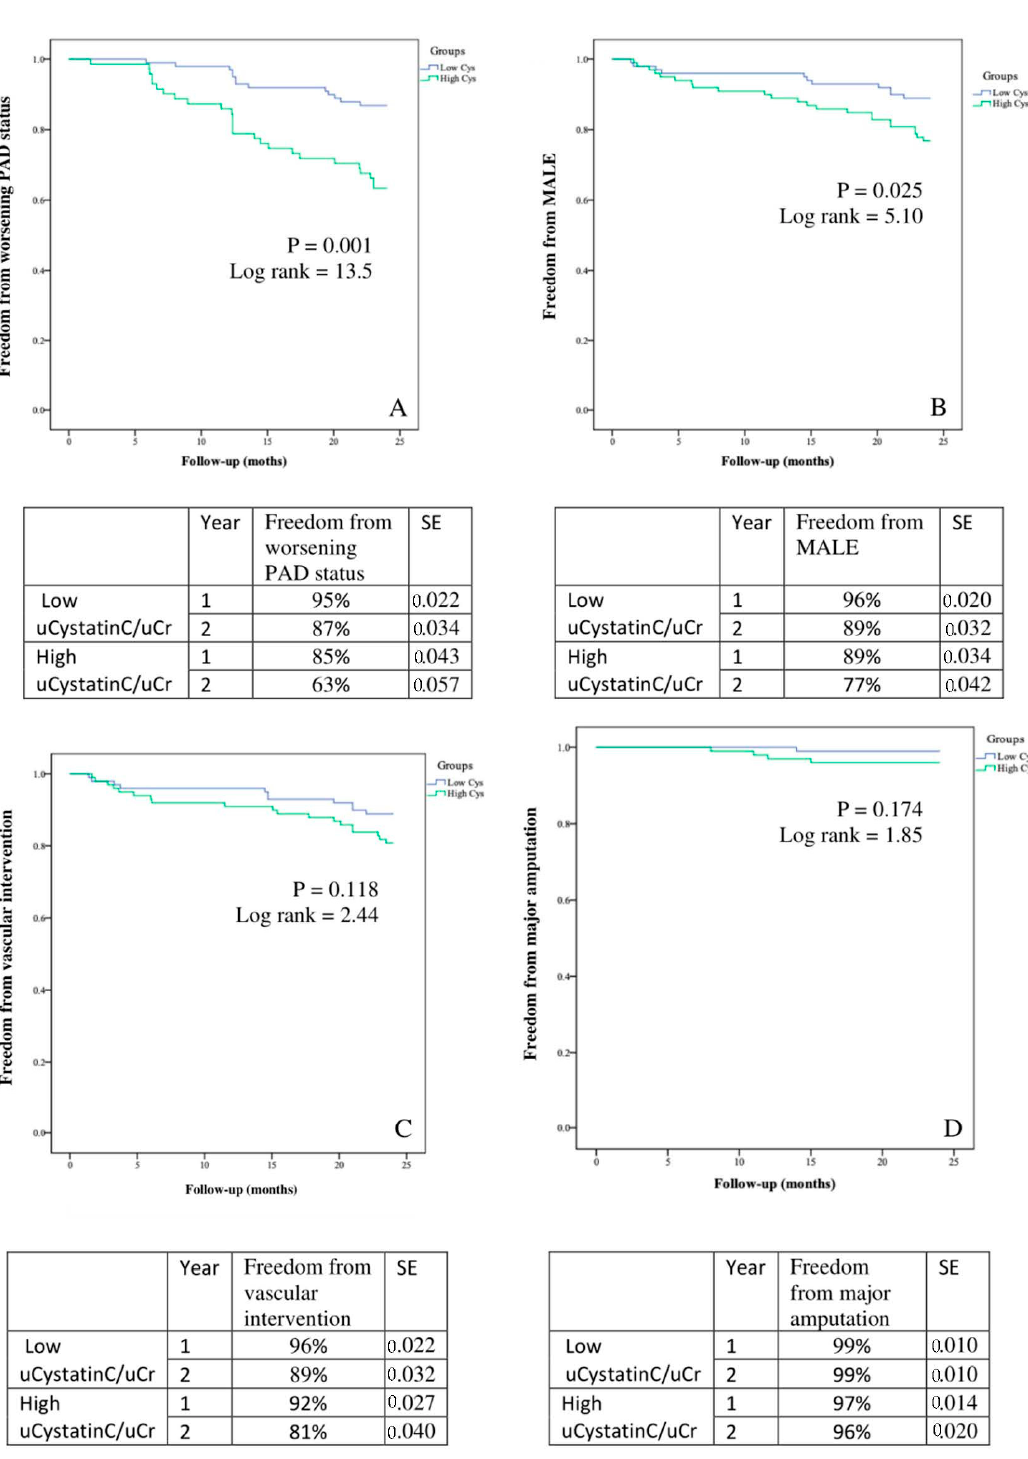
Figure 1. Kaplan–Meier analysis of event-free survival rates in patients with low vs. high urinary Cystatin C normalized to urinary creatinine (uCystatinC/uCr) for ( A ) worsening PAD (ankle-brachial index drop ≥ 0.15), ( B ) MALE (major adverse limb event), ( C ) vascular intervention, and ( D ) major amputation. SE = standard error.